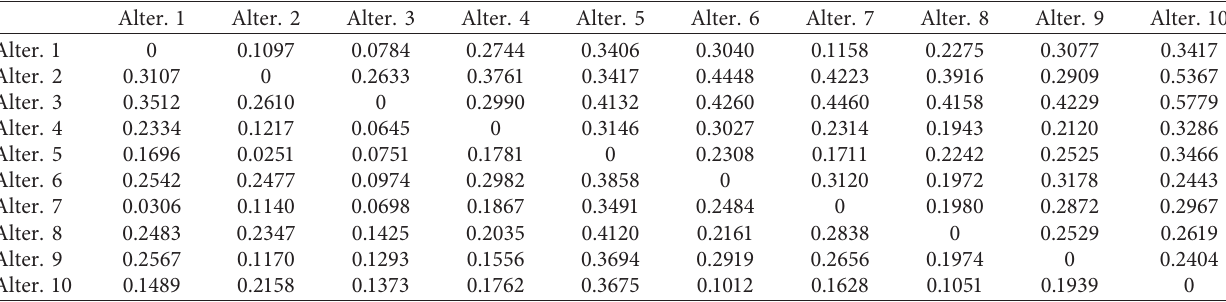
Table 13: The weighted preference degree